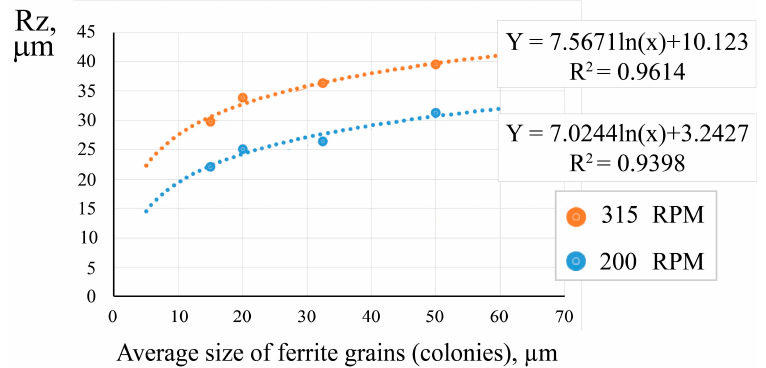
Figure 13. Influence of ferrite colony size on the surface roughness of 38Kh Н 3 М FA steel under dry friction conditions.